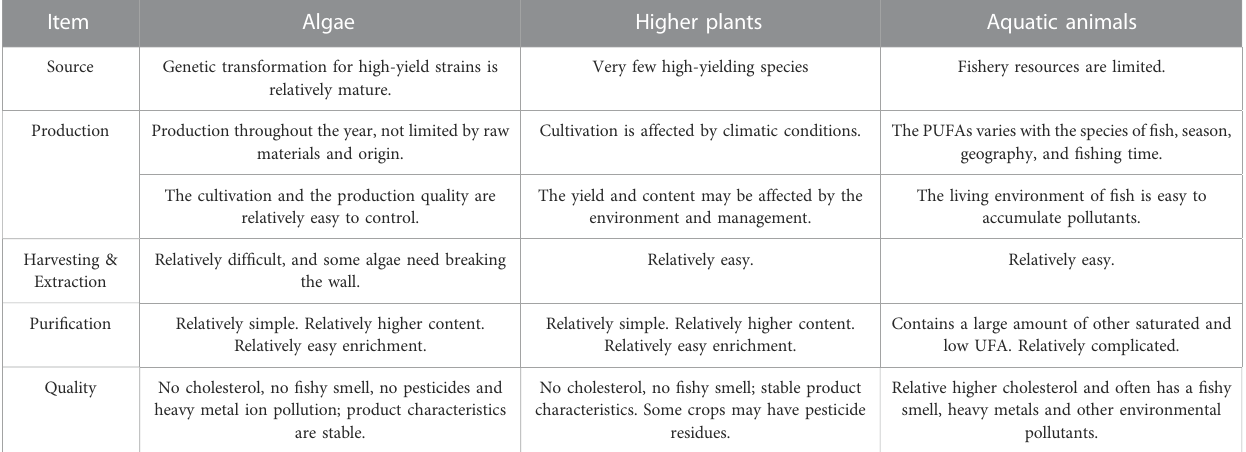
TABLE 4 Comparison of PUFAs production by algae, higher plants and aquatic animals. Item Algae Higher